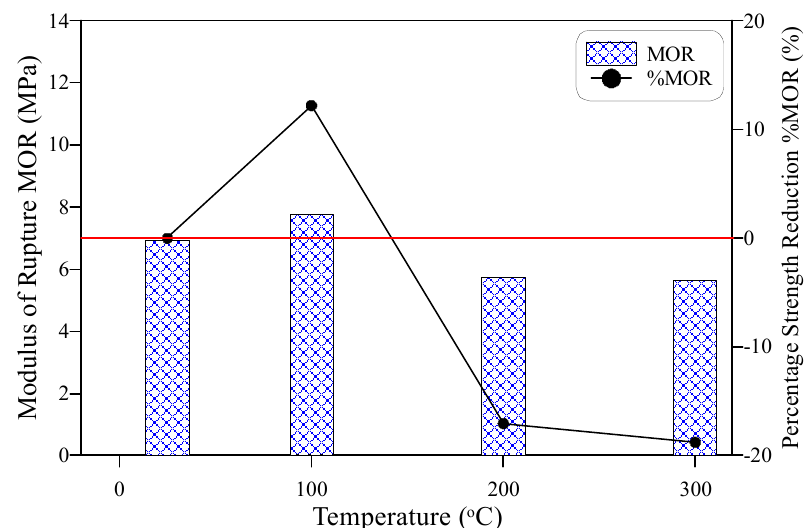
Figure 7. Modulus of rupture-temperature behavior.